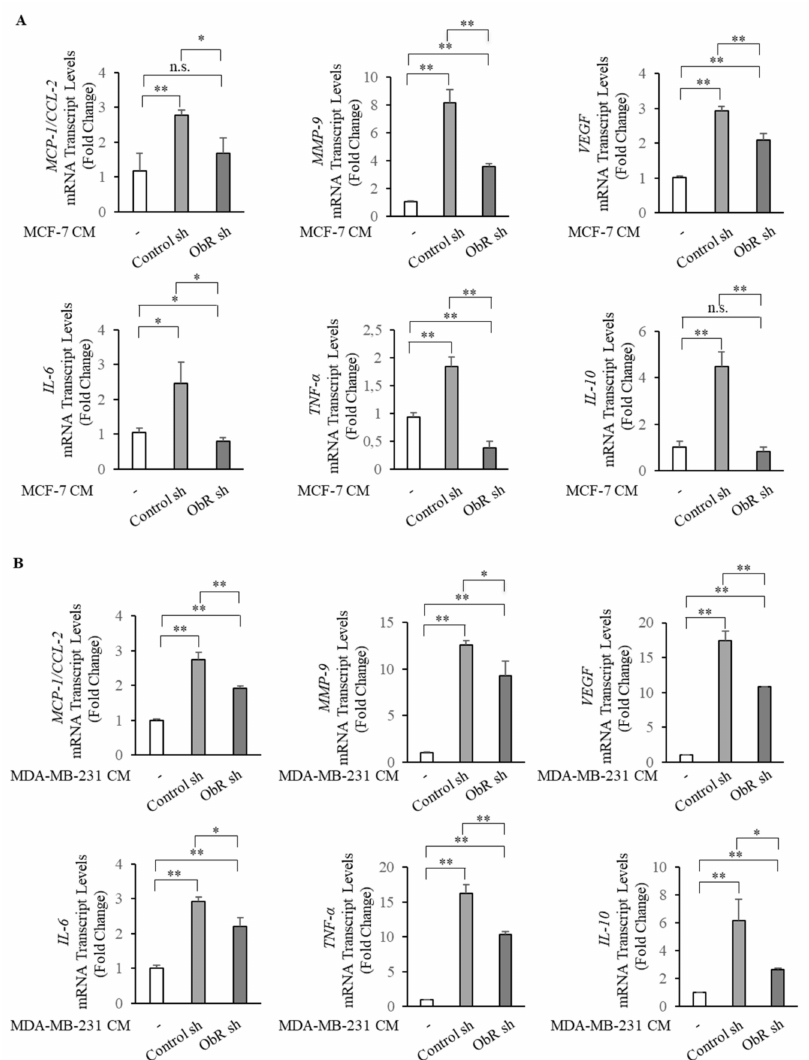
Figure 6. ObR knockdown in breast cancer cells a ff ects the mRNA expression profile of tumor-associated macrophages (TAMs). THP-1 cells were stimulated with phorbol 12-myristate 13-acetate (PMA, 100 nM) for 14 h followed by 24 h rest to obtain THP-1 macrophage-like cells (M0). Real-time RT-PCR assay for MCP-1 / C-C motif chemokine ligand 2 ( MCP-1 / CCL-2 ), matrix metalloproteinase-9 ( MMP-9 ), tumor necrosis factor alpha ( TNF- α ), vascular endothelial growth factor ( VEGF ), interleukine-6 ( IL-6 ), inteleukine-10 ( IL-10 ) in M0 treated with 5% charcoal stripped media (-) or incubated with conditioned media (CM) derived from Control sh and ObR sh MCF-7 breast cancer cells for 5 days ( A ) and from MDA-MB-231 breast cancer cells for 3 days ( B ). The values represent the mean ± SD of three di ff erent experiments, each performed in triplicate. n.s., nonsignificant; * p < 0.05; ** p <